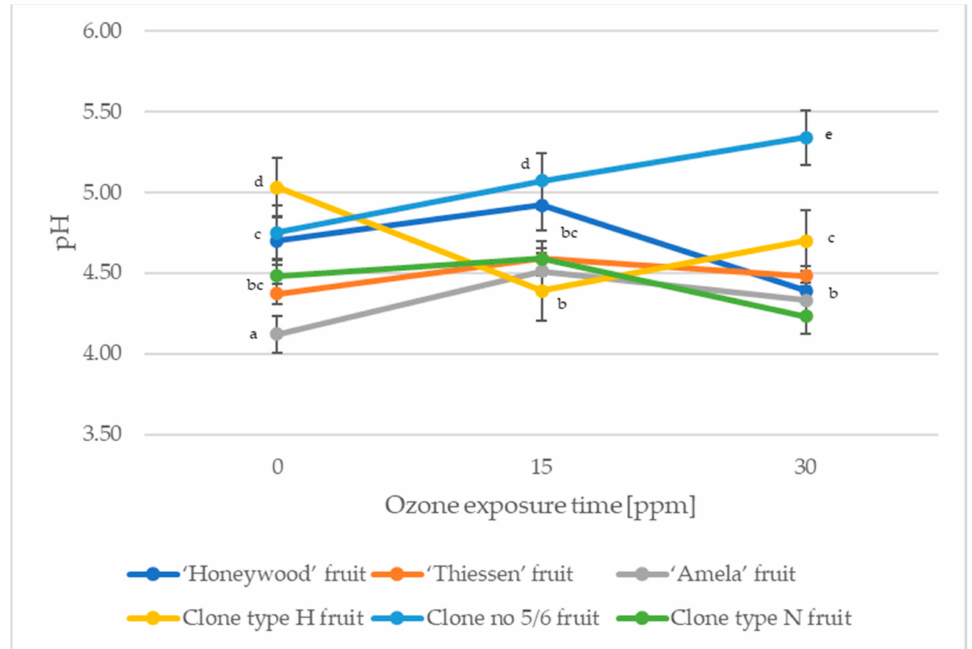
Figure 1. Changes in the pH of the Saskatoon berry during ozone exposure. Data are expressed as mean values (n = 3) ± SD; SD—standard deviation. Mean values with different letters are significantly different ( p < 0.05).